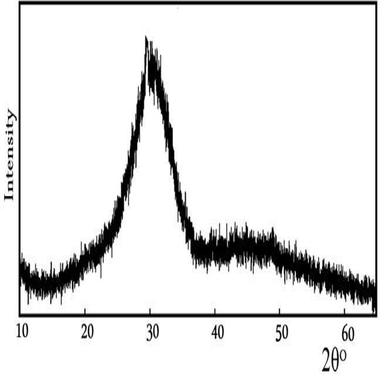
XRD pattern of granulated blast furnace slag.